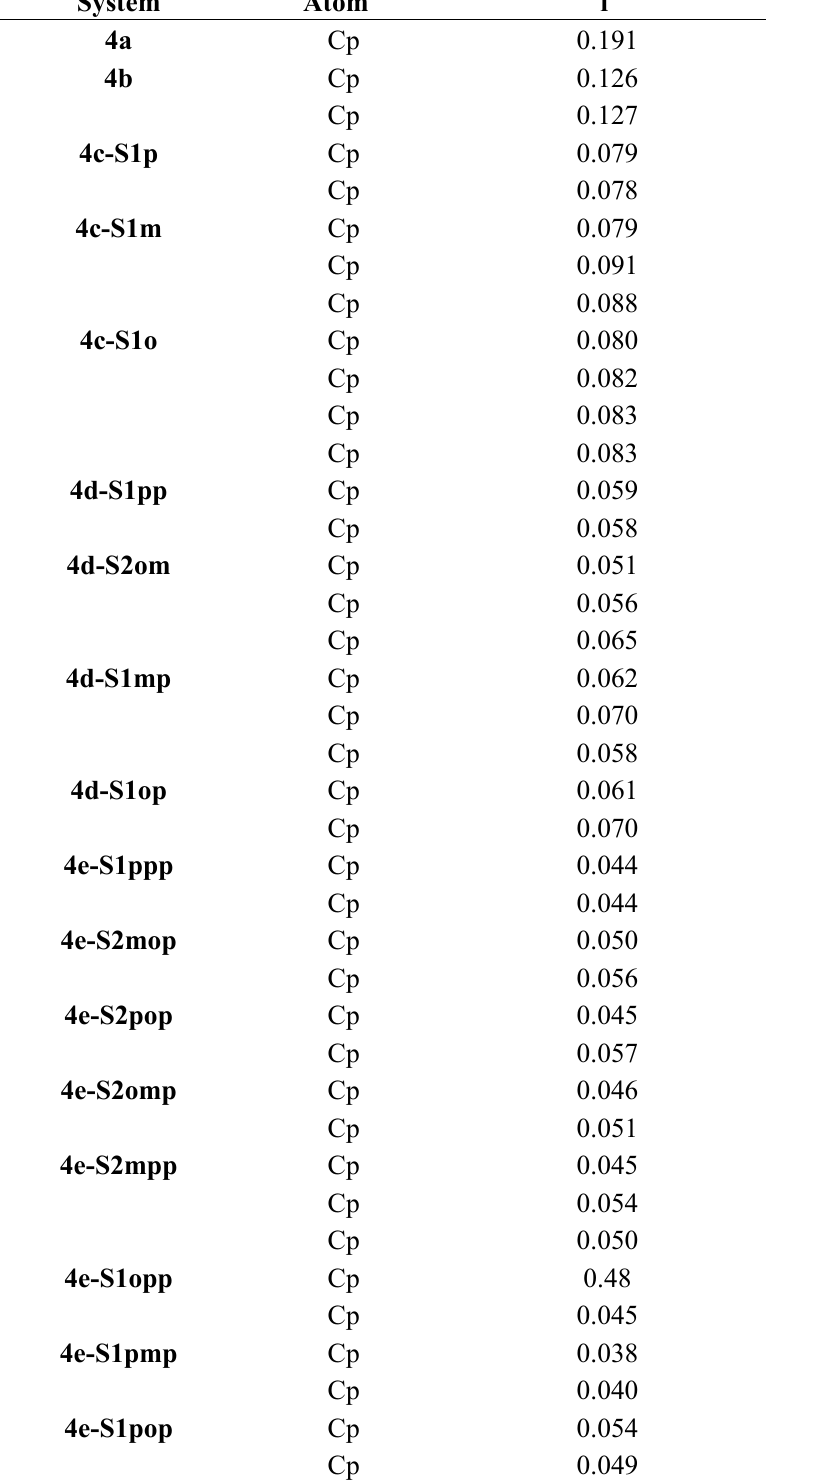
Table 6. Fukui indexe, f - , for selected atom, carbon atom, substitution in para